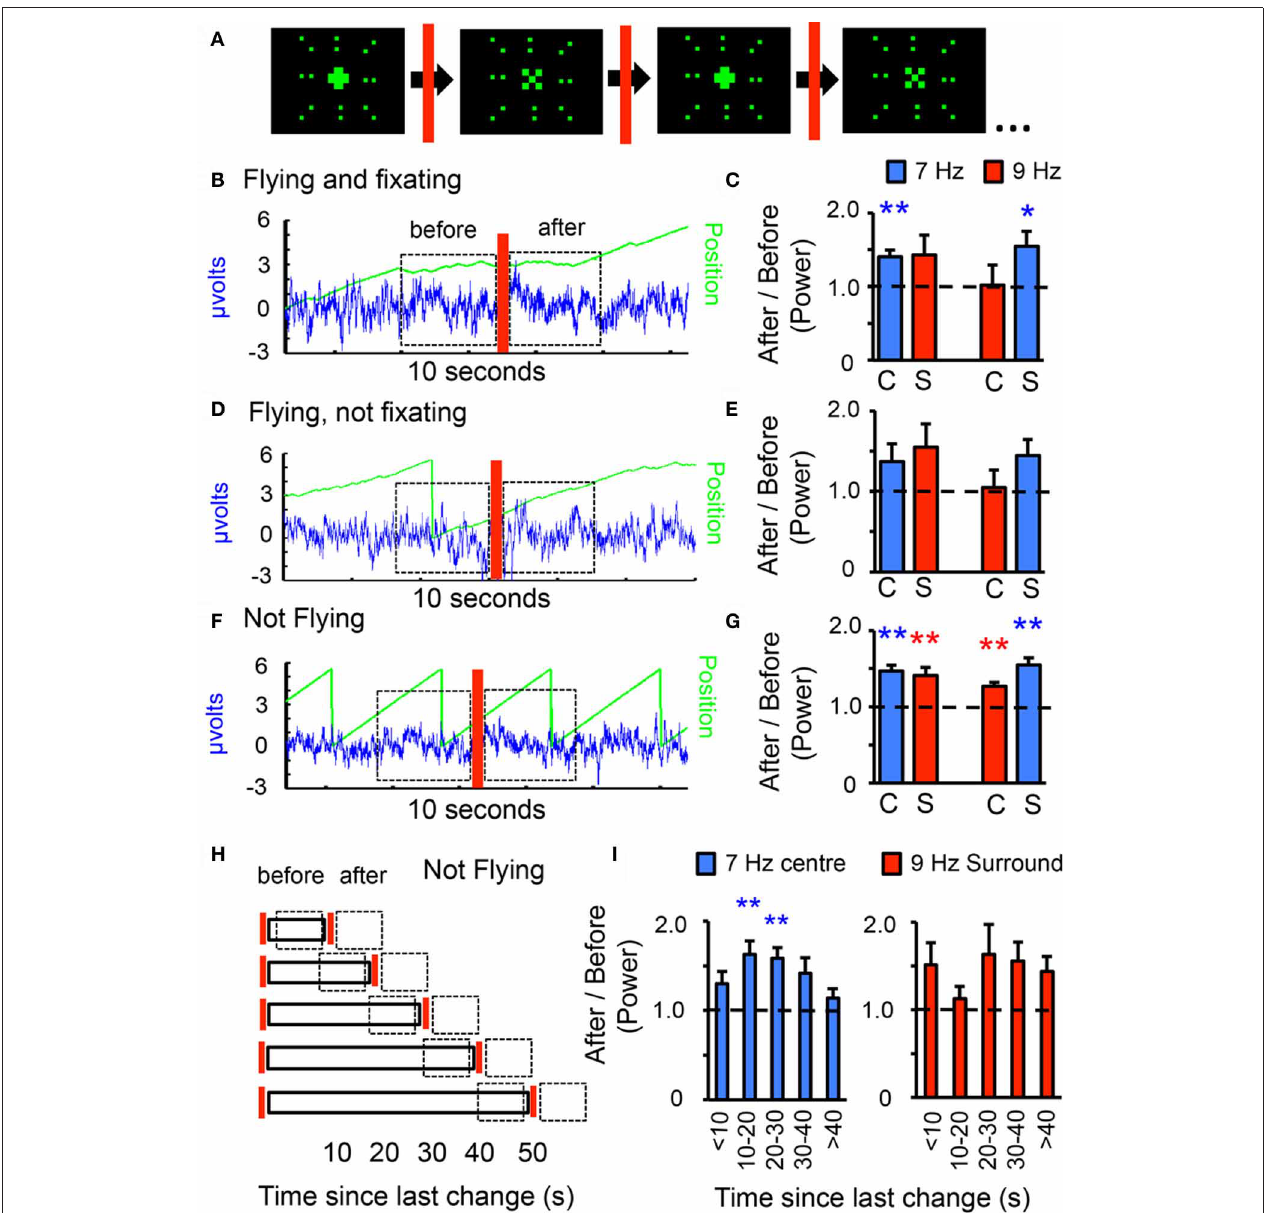
FIGURE 3 | Visual novelty modulates frequency tag power. (A) Center-surround pattern, with visual changes in the center. The central object flickering at 7 or 9Hz alternates between a 30 ◦ “ + ” and an “ × ,” with changes happening randomly every 5–50s. The changing central object is surrounded by an unchanging 90 ◦ surround composed of dots flickering in synchrony at 7 or 9Hz. (B) Epochs of behavioral fixation that included a visual change were analyzed for 7 and 9Hz power. Power for either frequency 3s after the change were contrasted, as a ratio, with 3s before the event (dashed boxes). Blue trace: LFP; green line: image position, as in Figure 1C . (C) 7 and 9Hz power after/before ratios for novelty events during fixation epochs, for either tag configuration. C, center; S, surround; n = 6 flies, ∗ P < 0 . 05, ∗∗ P < 0 . 01 by t- test compared to 1.0 (dashed line). (D) Novelty events occurring during flight epochs without fixation were analyzed for 7 and 9Hz power before and after the visual change in the center. (E) 7 and 9Hz power after/before ratios for